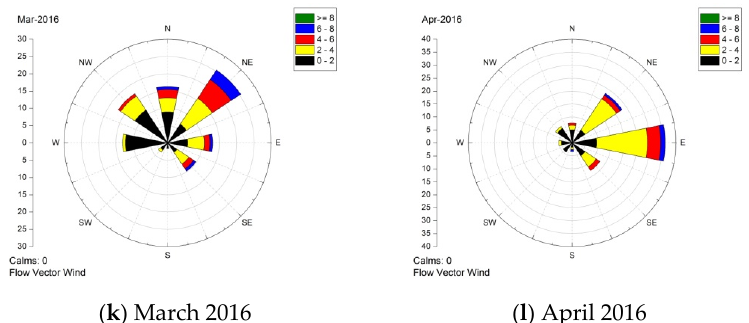
Figure 1. Six-hour wind direction variations in Xiamen during the period from May 2015 to April 2016.